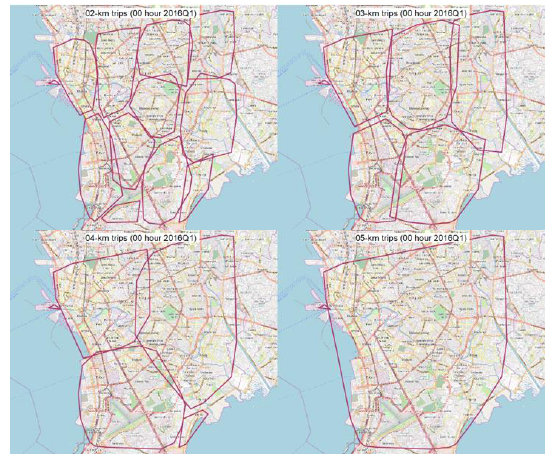
Figure 6. Clustering (as indicated by red polygons) for different distance filters in 00 hour of the day